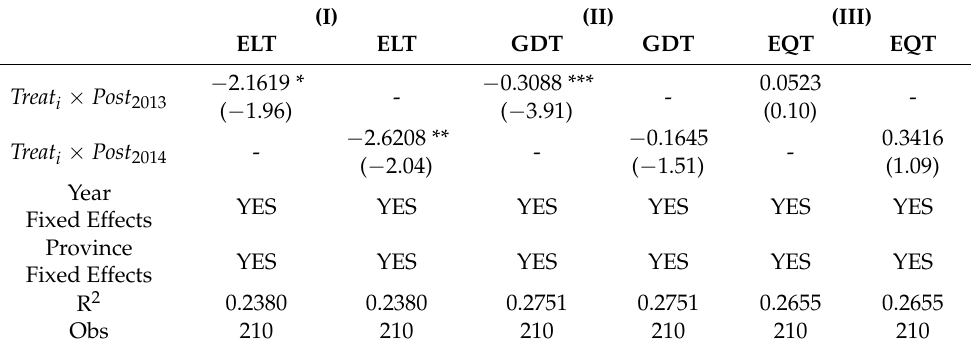
Table 3. Baseline regression results for the three dimensions of